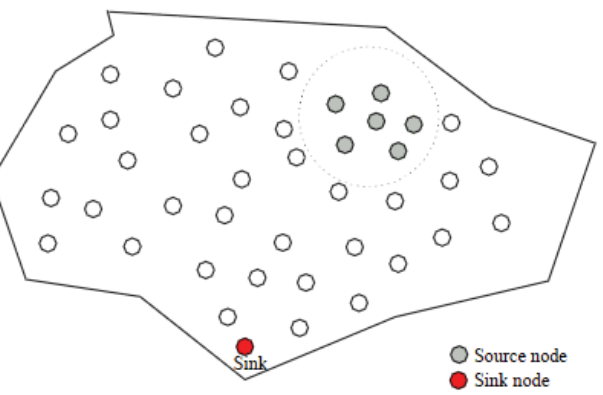
Figure 1. WSN with sink